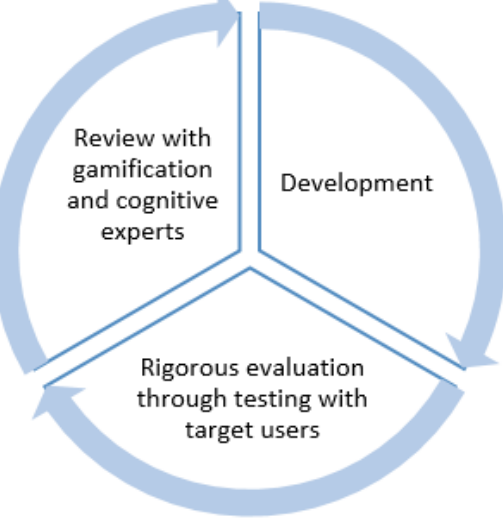
Figure 6. Overall structure of the development